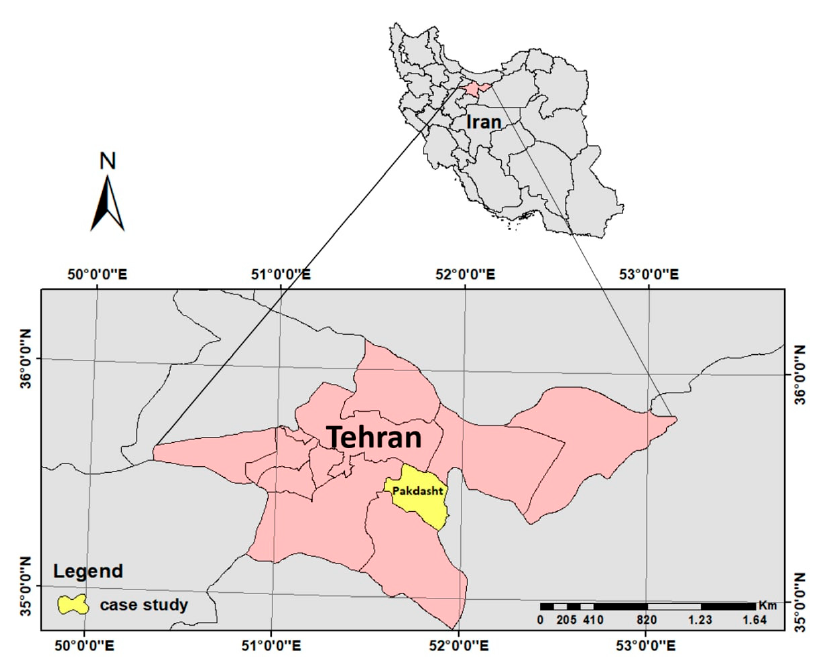
Figure 1. The geographical location of Pakdasht city (35.4669° N, 51.6861° E), Tehran province, Iran. Table 1. Average minimum and maximum daily air temperatures and monthly total precipitation during the summer maize growing season from June through November of 2018 and 2019 in Pakdasht city,